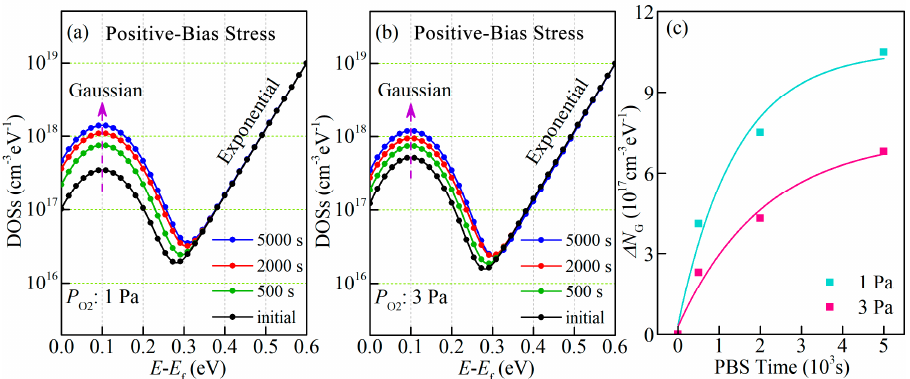
Figure 5. Calculated DOSs as a function of PBS time for a-IGZO TFTs fabricated with different Po 2 values: ( a ) 1 Pa and ( b ) 3 Pa; ( c ) the shift of N G for a-IGZO TFTs fabricated with Po 2 values of 1 Pa and 3 Pa.